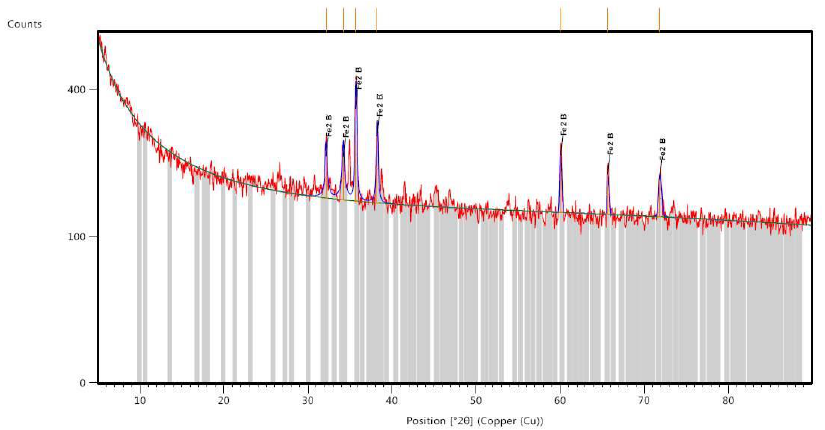
Fig.3. X-ray diffraction patterns of boronized X52